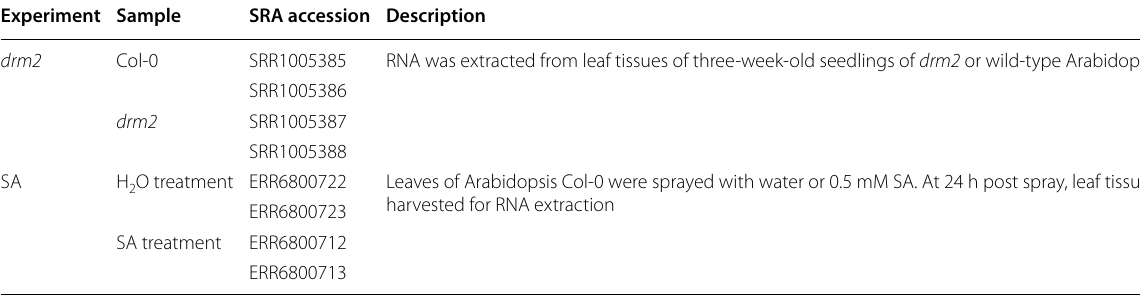
Table 2 Information of RNA-Seq data used for transcriptome analysis Experiment